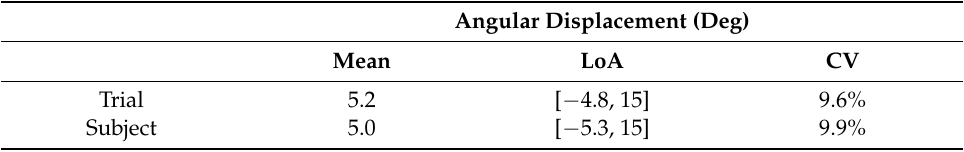
Table 4. Comparison of GO Algorithm with Vicon KAV Integral. Bland–Altman analysis of peak swing flexion detected from GO and